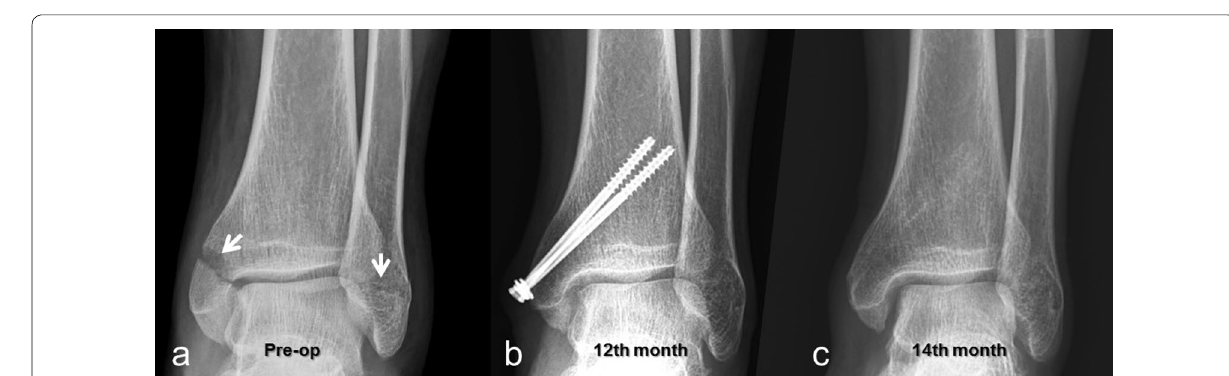
Fig. 1 a Preoperative anteroposterior (AP) ankle radiograph of 44-year-old male patient with bimalleolar fracture (white arrows showing fractures); b At 12-month follow-up, fracture was united, but patient had pain over medial malleolus; c AP ankle radiograph 2 months after removal of screws